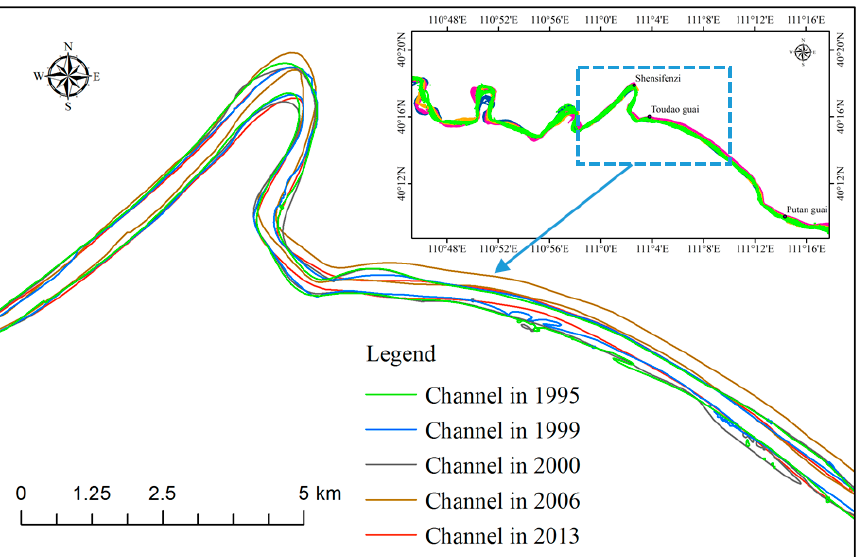
Figure 10. Channel evolution of research area and the enlarged view of Shensifenzi bend during 1995–2013.